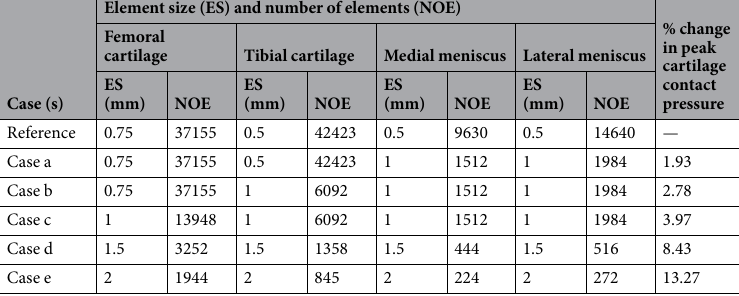
Table 2. Sensitivity analyses on mesh density for different knee